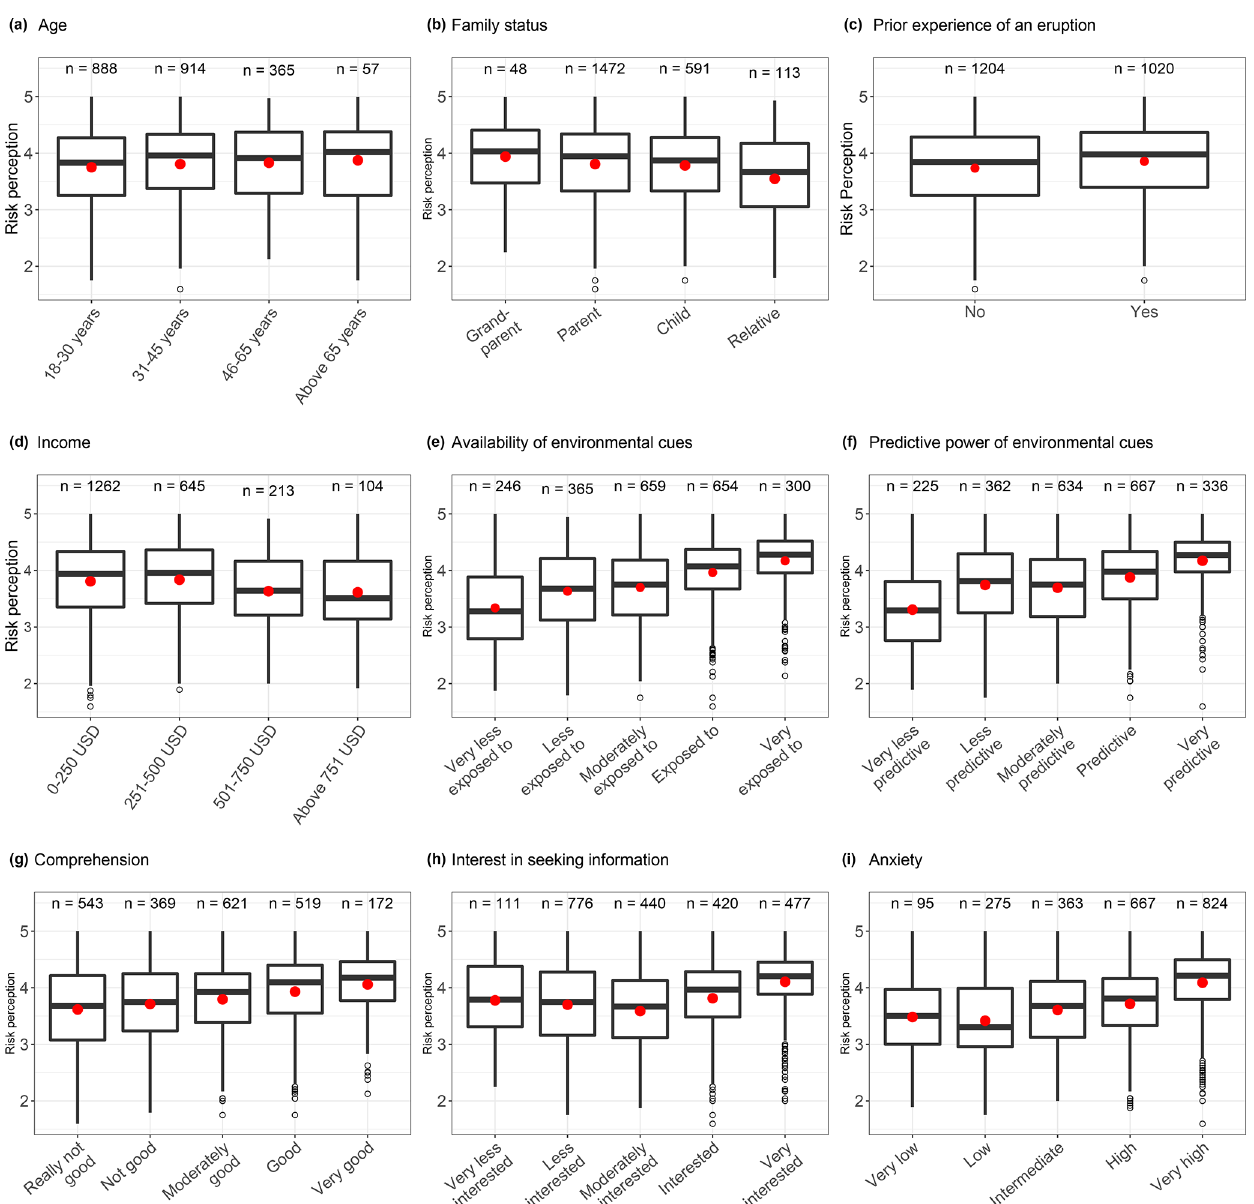
Figure 5. The level of risk perception according to significant determining factors. The level of risk perception is in a numerical scale from 1 (very low) to 5 (very high). In each boxplot, the horizontal bold line represents the median, the red dot indicates the mean and the small circles indicate the outliers. Apart from family status and experience of a volcanic eruption, the levels of each factor are in an ascending